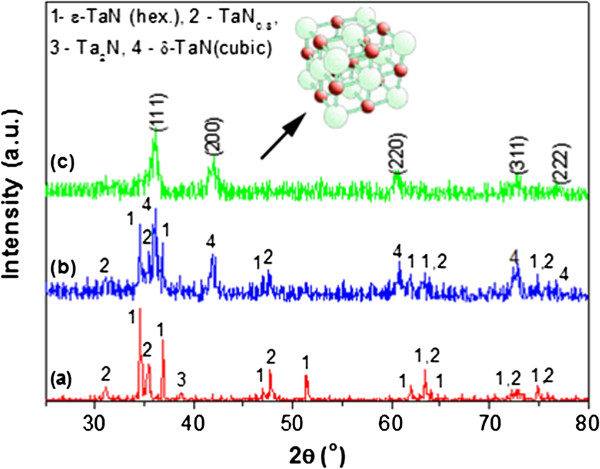
XRD patterns of water-purified powders synthesized from K2TaF7 + (5 + k)NaN3 + kNH4F mixture. (a) k = 0, (b) k = 2.0, and (c) k = 4.0.